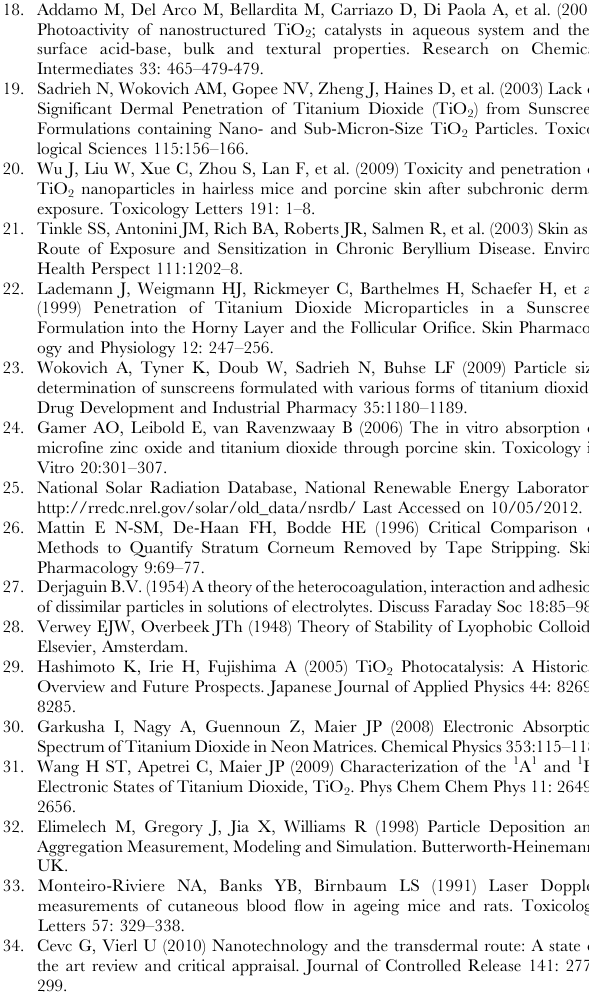
clearly present after 30 min irradiation. Similarly, the intensity of smaller particles also increases after irradiation. (TIFF) Figure S4 The mass (absorbance) of corneocytes removed with each section via tape stripping from both the light and dark exposed skin grafts (Panel A). Panel B presents the amount TiO 2 found per section normalized by the mass of corneocytes removed with each section. (TIFF) Table S1 The polydispersity index (PDI) results for sunlight experiments are presented in Table S1 for unirradiated